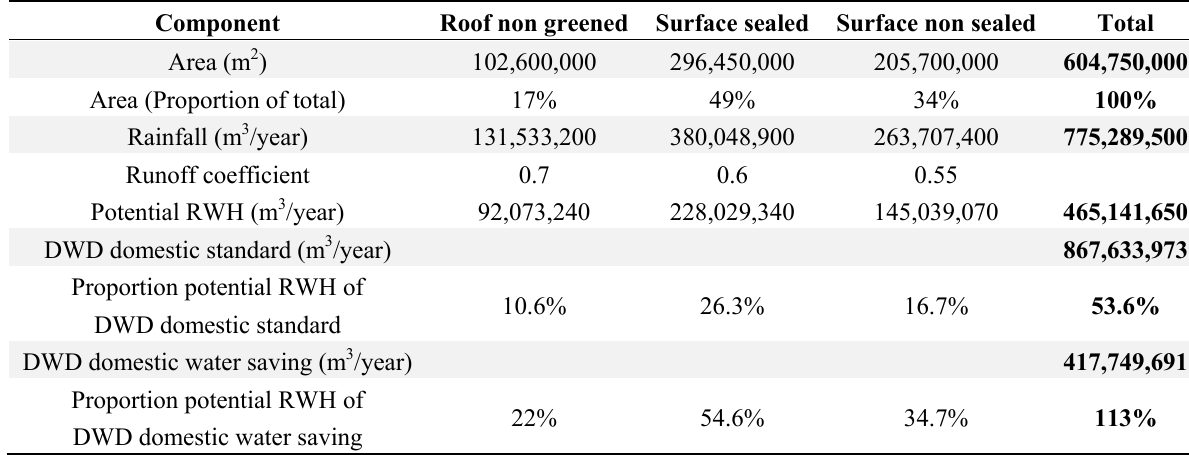
Table 2. Rainwater harvesting potential at city level for Seoul, Republic of Korea